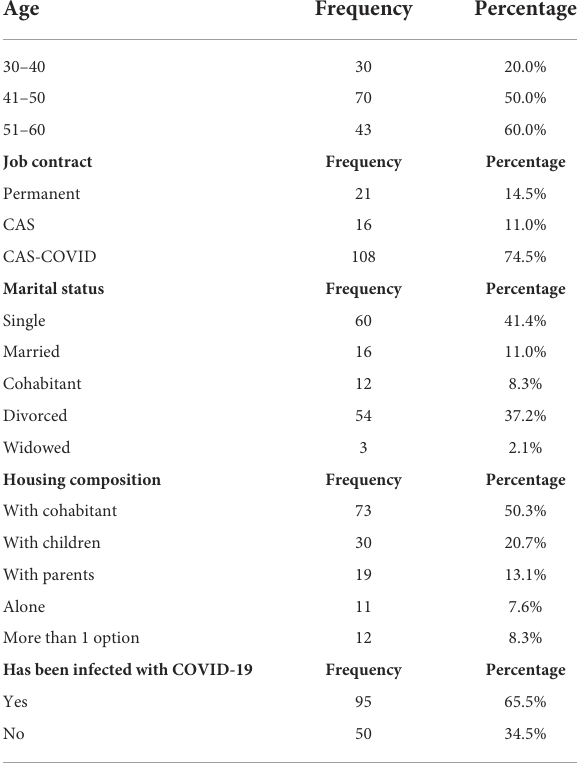
TABLE 1 Sociodemographic characteristics of the nursing